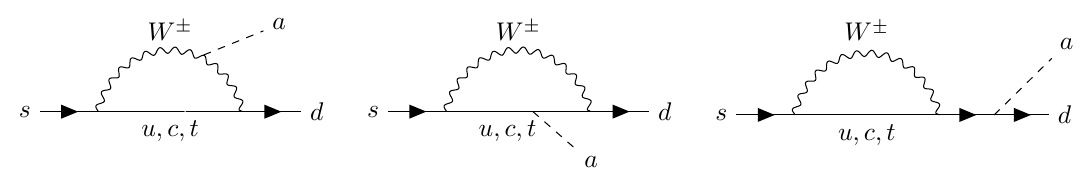
Figure 1 . One-loop diagrams inducing the flavour-violating s → d + a transition. We include the self-energy contribution on the external strange-quark leg (analogously for the down-quark line) arising from the renormalization of quark fields, see appendix D. All Feynman diagrams throughout this work are drawn using the TikZ-Feynman [111]